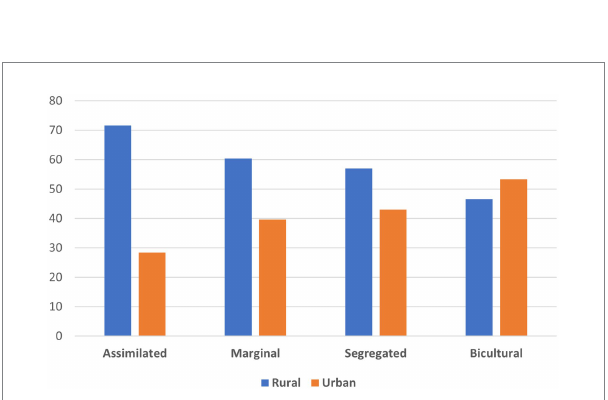
FIGURE 2 Percentage of acculturation orientation by urban and rural